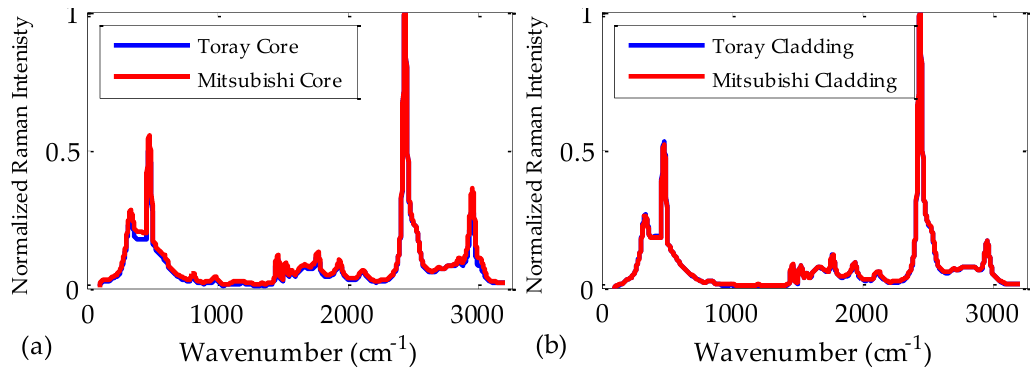
Figure 7. Normalized Raman spectrum measured for the cores ( a ) and for the claddings ( b ) of two different brands of fiber: Toray (blue lines) and Mitsubishi (red lines). With both manufacturers, the core is made of PMMA and the cladding is made of a fluorinated polymer.